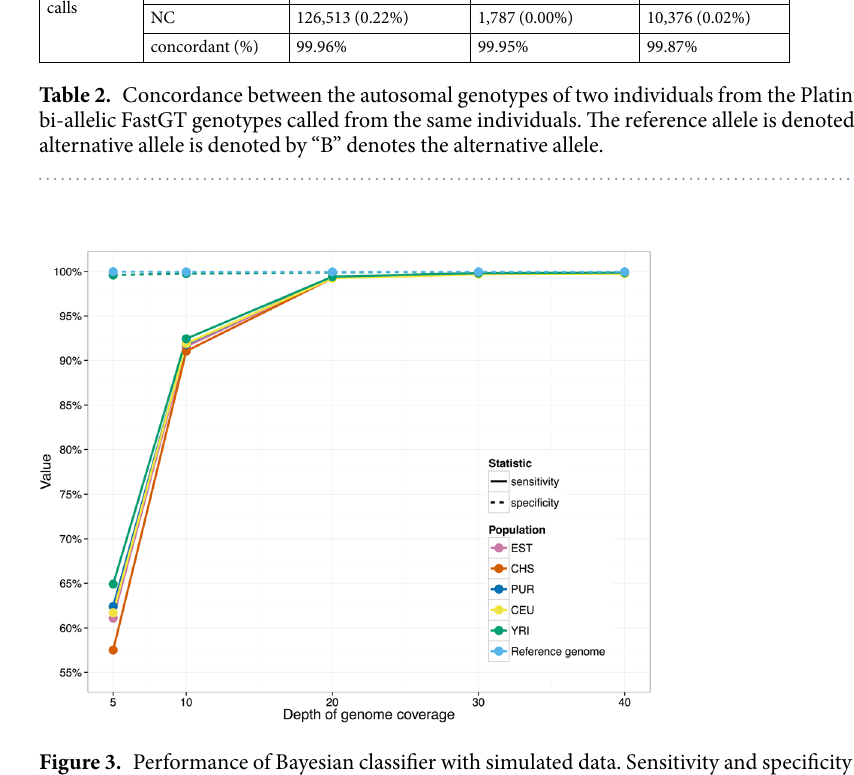
The overall concordance of bi-allelic FastGT genotypes with genotypes from two Platinum genomes is 99.96%. The concordance of the non-reference (AB or BB) calls was 99.93%. The distribution of differences between the two sets for different genotypes is shown in Table 2. All of the genotypes reported in the Platinum datasets were bi-allelic; thus, we included only bi-allelic FastGT genotypes in this comparison. The fraction of uncertain (no-call) genotypes in the FastGT output was 0.24%. The uncertain genotypes are primarily mono-allelic (A) and tri-allelic (AAA) genotypes that might correspond to deletions or insertions in a given region. However, non-canonical genotypes in the default output are not reported, and they are replaced by NC (“no call”). All of the genotypes and/or their likelihoods can be shown in gmer_caller optional output. We also compared the genotypes obtained by the FastGT method with the data from the Illumina HumanOmniExpress microarray. We used 504,173 autosomal markers that overlap our whole-genome data- set (Table S2), and the comparison included ten individuals from the Estonian Genome Center for whom both